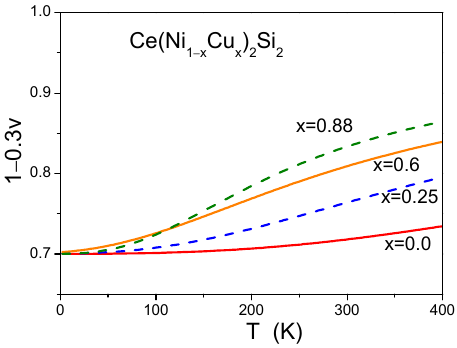
Figure 5. Occupancy of the f states as a function of temperature derived from the thermoelectric power S ( T ) for Ce(Ni 1 − x Cu x ) 2 Si 2 .